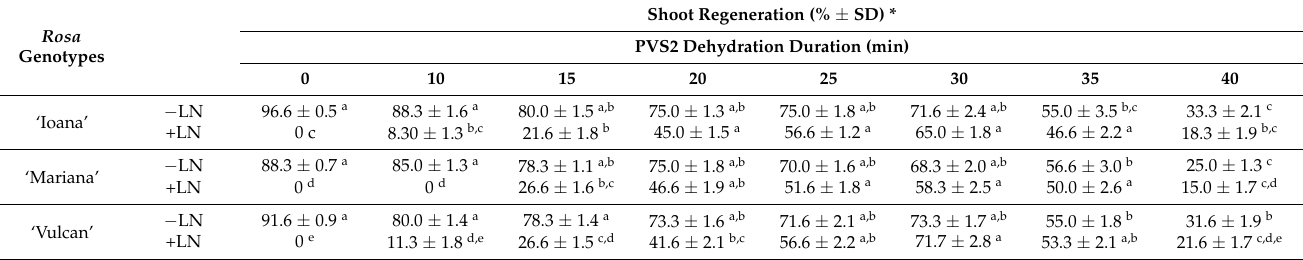
* Values are expressed as means ± standard deviation (SD). Shoot tips were osmoprotected in 0.75 M sucrose for 24 h. Values followed by the same letter within a row are not significantly different ( p ≤